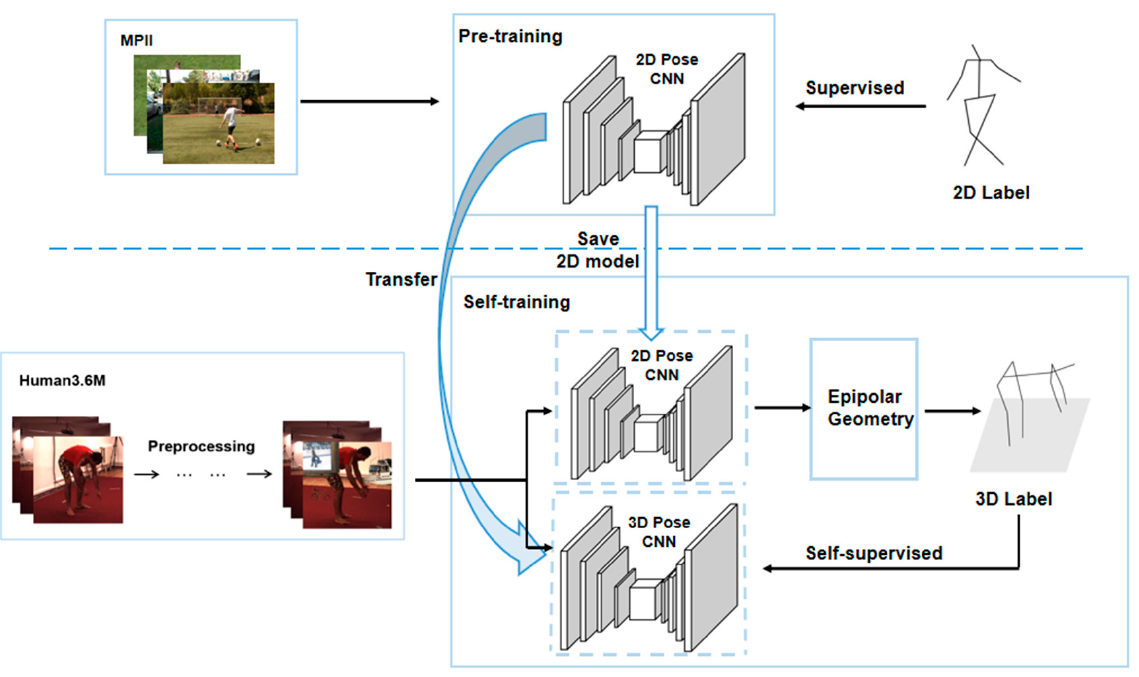
Figure 9. Training process of Pose ResNet.